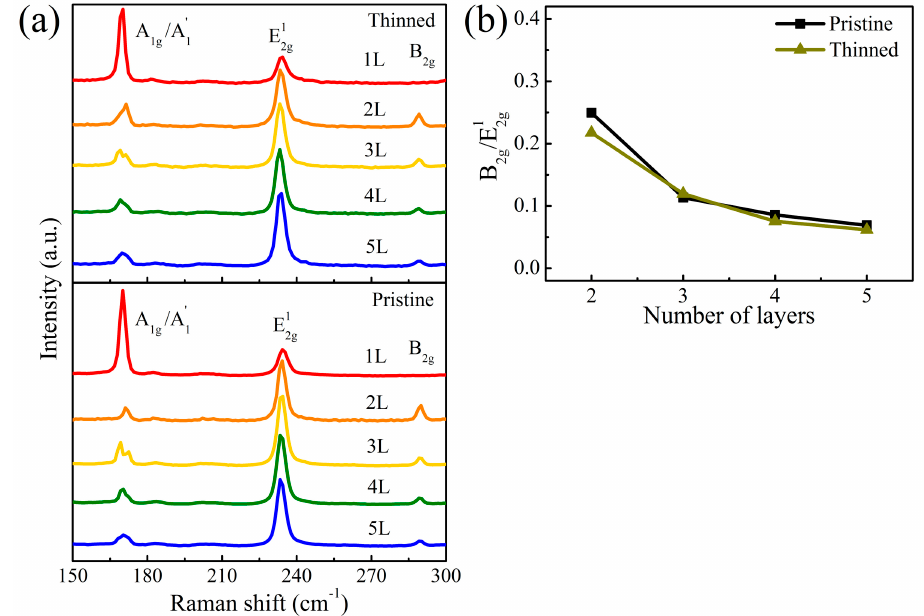
Figure 2. ( a ) Raman spectra for pristine and thinned MoTe 2 . All spectra are offset vertically for clarity. ( b ) The relationship between peak intensity ratio of B 2g /E 2g1 and the layer number for pristine and thinned MoTe 2 .